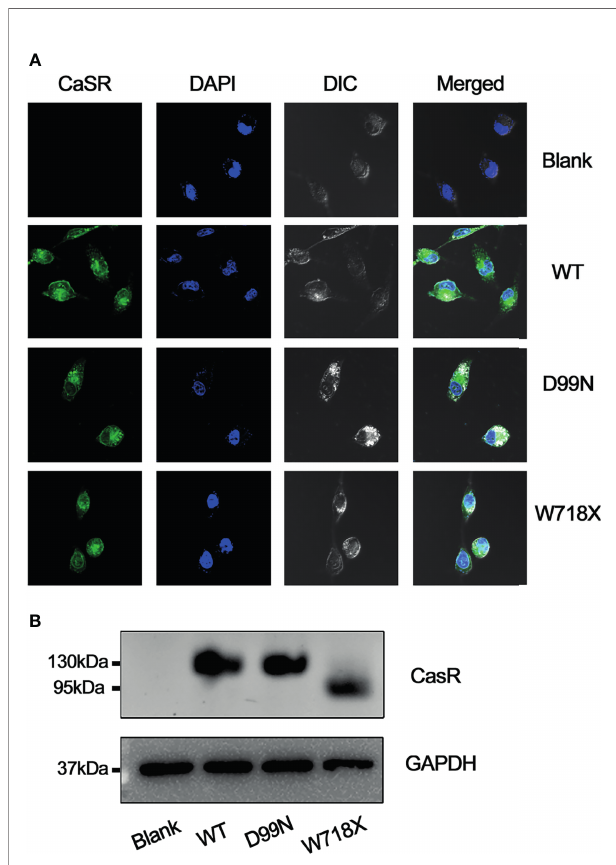
FIGURE 4 | Analysis of CaSR protein expression. (A) Expression of CaSR in blank, WT, D99N, and W718X HEK-293 cells was analyzed by immuno fl uorescence confocal microscopy (1000X) following incubation with a monoclonal anti-CaSR antibody. Green fl uorescence indicates CaSR and blue fl uorescence (DAPI) indicates the cell nucleus. (B) Western blot analysis. Proteins extracted from untransfected HepG2 cells (blank) and HepG2 cells transfected with human wild-type CaSR (WT) or mutant CaSR (D99N and W718X) were subjected to SDS-polyacrylamide gel electrophoresis, western blotting, and visualization using an anti-CaSR monoclonal antibody. GAPDH was used as a loading